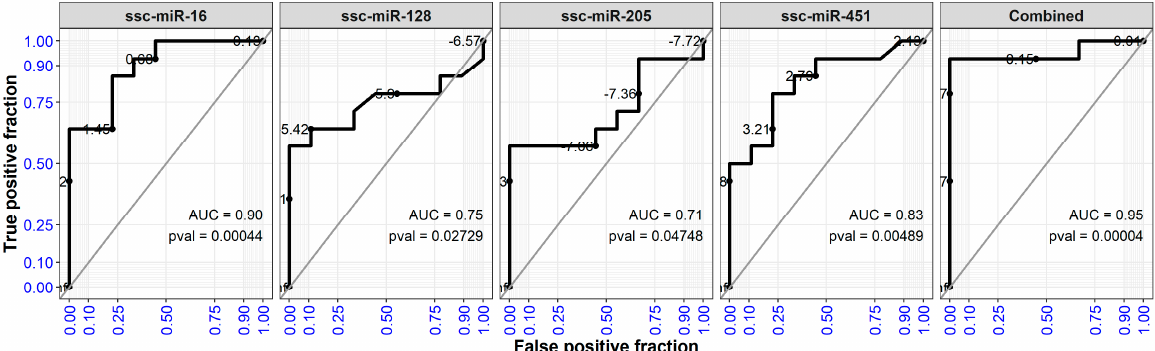
Figure 6. ROC analysis based on microRNA expression measured by qPCR for serum samples at day 26. For this analysis, DON_LOW and DON_HIGH samples were pooled together as the treated group and compared to the Control. The Combined ROC curve shows the analysis based on the logistic regression model using a combination of these four microRNAs.